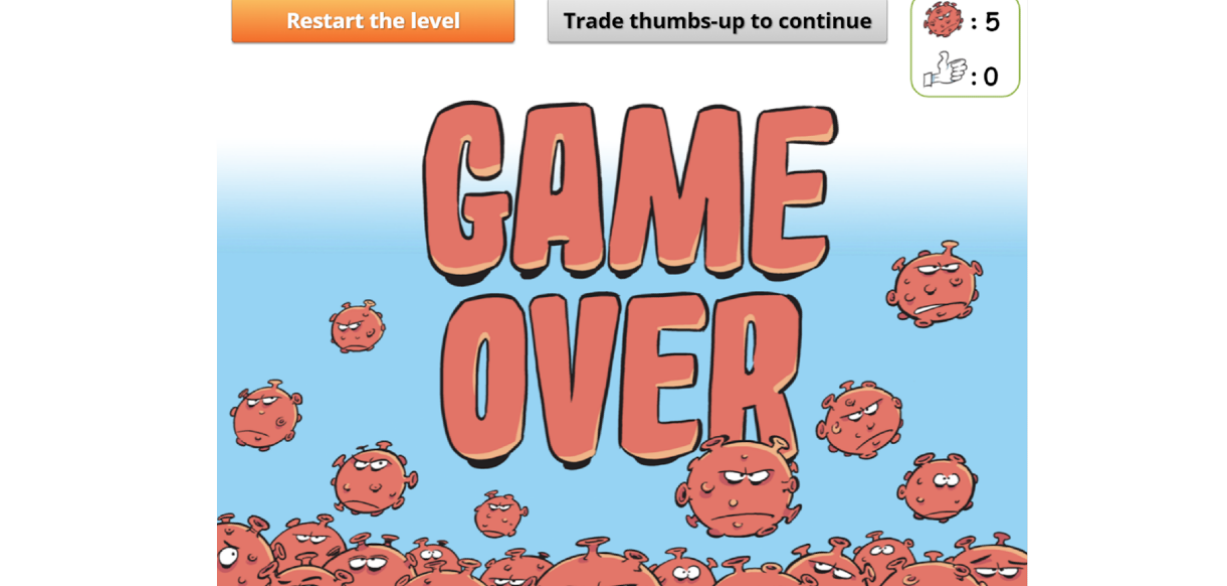
Figure 7. "Game over" screen of the Escape COVID-19 serious game.